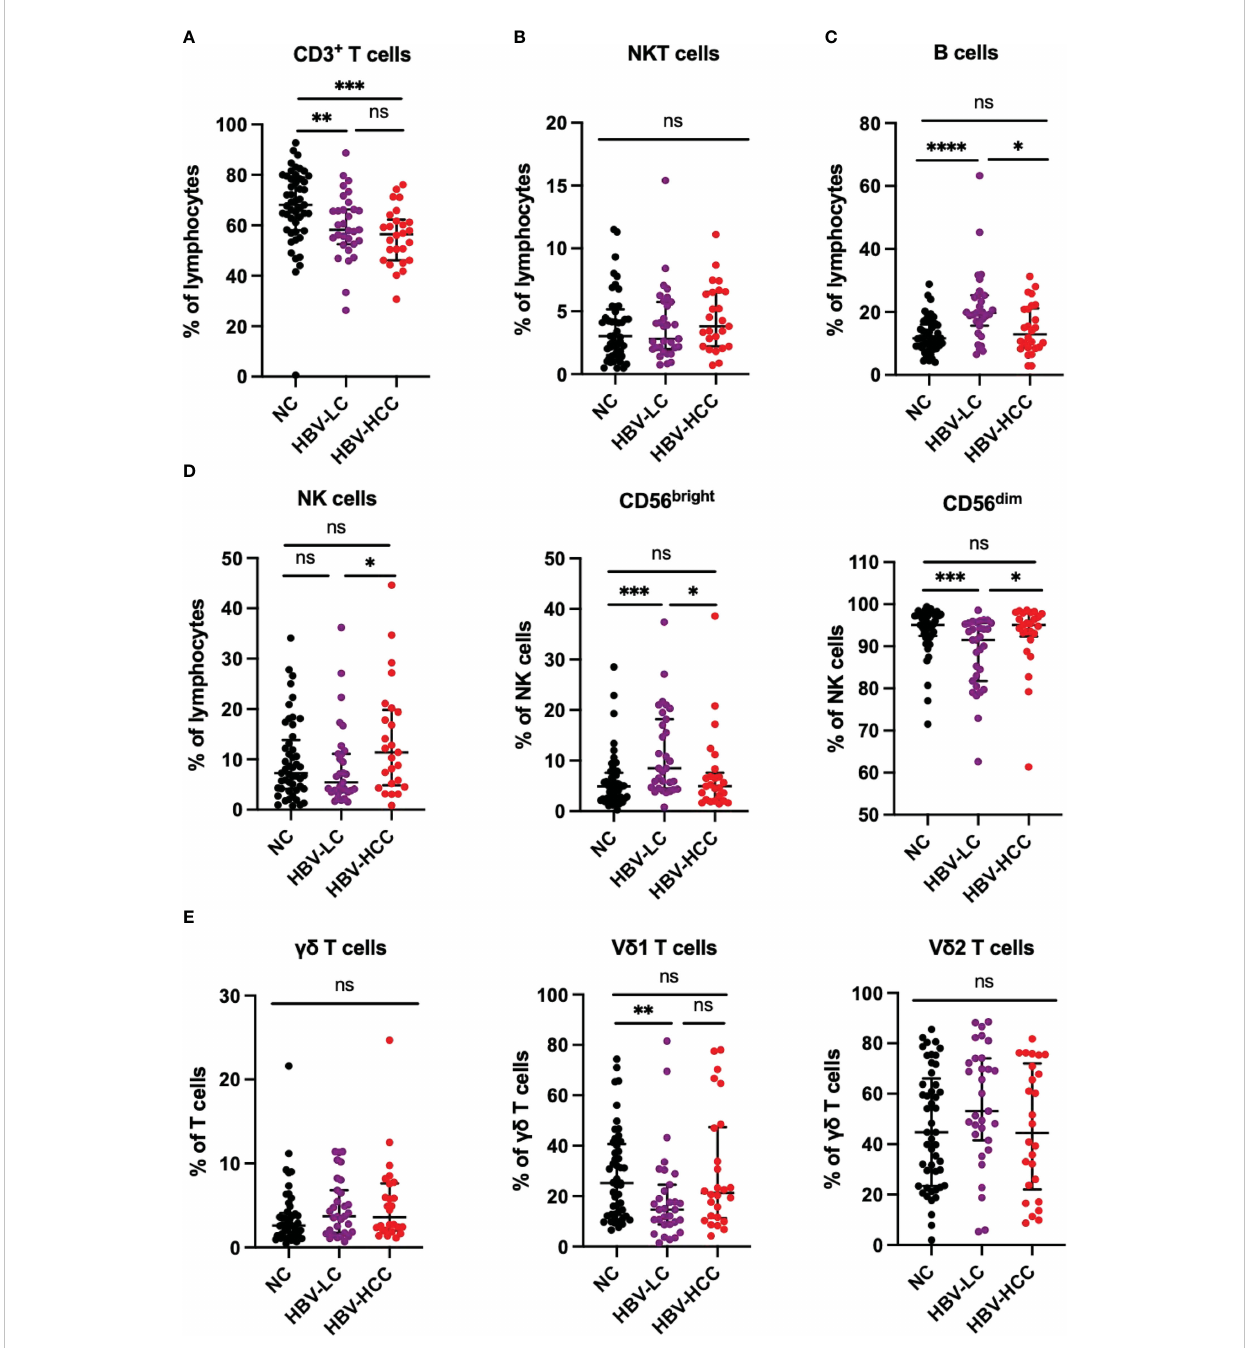
FIGURE 1 Peripheral circulating lymphocytes from NC (n=49), HBV-LC (n=31) and HBV-HCC (n = 26) patients were analyzed by multiparameter fl ow cytometry. (A) Frequency of CD3 + T cells in peripheral blood lymphocytes. (B) NKT cell (CD3 + CD56 + ) frequency in peripheral blood lymphocytes. (C) Frequency of B cells in peripheral blood lymphocytes. (D) NK cells (CD3 - CD56 + ) were further classi fi ed into CD56 bright NK cells and CD56 dim NK cells according to CD56 expression. (E) Circulating gd T cells (CD3 + gd TCR + ) and their subsets V d 1 and V d 2 frequencies. The ANOVA or Kruskal- Wallis test was used to determine statistical differences between the three groups. * p <0.05, ** p <0.01, *** p <0.001, **** p <0.0001. ns, not signi fi